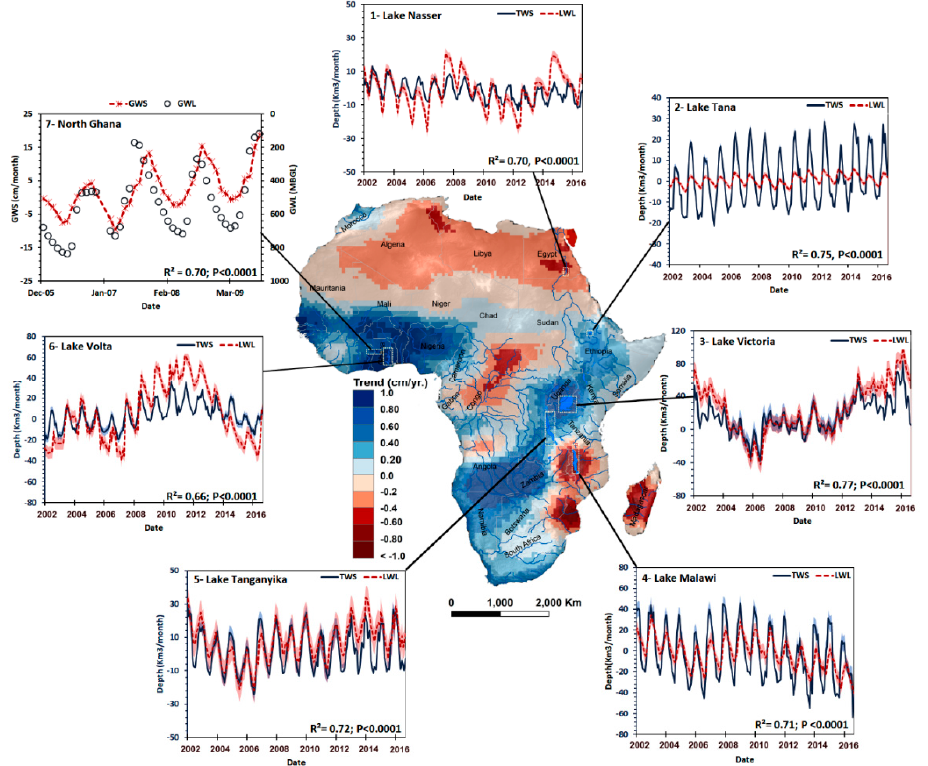
Figure 2. Total Water Storage (TWS) trend across Africa between 2002 and 2016 derived using the Center for Space Research (CSR)-M data. The trend map shows a varying TWS across Africa with a remarkable decline in North Africa, Congo basin in the west, Lake Malawi, Limpopo river basin, and Madagascar in South Africa. There is a positive increase in TWS in the Sahel region in the west, Okavango river basin in the south, Lake Victoria, and Lake Tana. The TWS signals from CSR-M were compared with lake water level (LWL) observations across six major lakes. Noteworthy, the majority of the lakes have aerial coverage less than the original Gravity Recovery and Climate Experiment (GRACE) satellite footprint; however, there is good consistency between GRACE signals and lake level anomalies ( p -value < 0.0001). The uncertainty bounds are computed for the TWS and LWL as introduced in Section 2.5. Additionally, groundwater storage estimates from GRACE, based on Equation (6), were compared to groundwater levels (meter below ground level-MBGL) that were averaged from 20 groundwater wells in North Ghana. The in-situ groundwater observation covers the period from December 2005 to December 2009. The GRACE-based groundwater observations show good agreement with the in-situ data ( p -value < 0.0001).